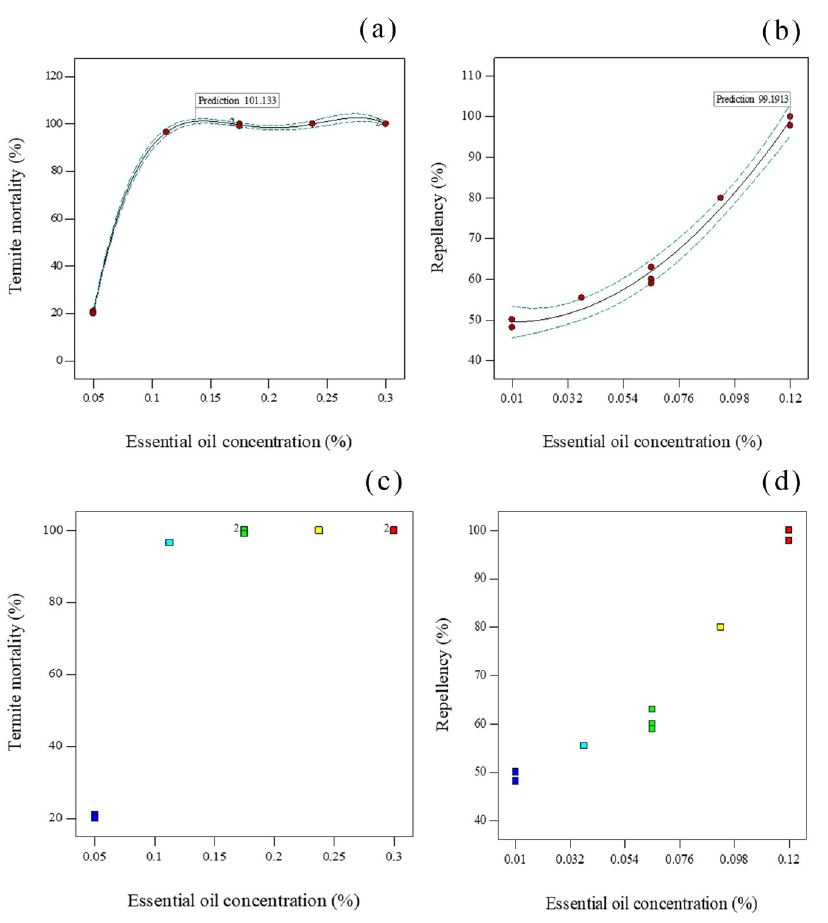
Figure 2. Model graph for one-factor design: ( a ) termite mortality, ( b ) repellency. Correlation between concentration and response variables: ( c ) termite mortality (0.770), ( d ), repellency (0.947).